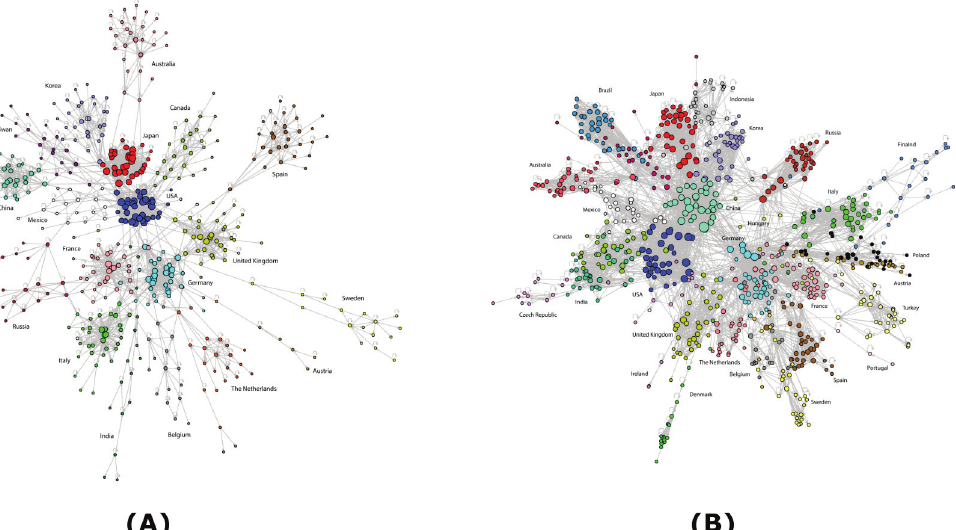
Fig 2. The WION in 1995 and 2011. Each node represents a certain industry in a certain economy. The size of the node is proportional to its total degree (number of edges). The edges are directed and only those with strength greater than 1000 millions of US dollars are present. Finally, different colors represent different